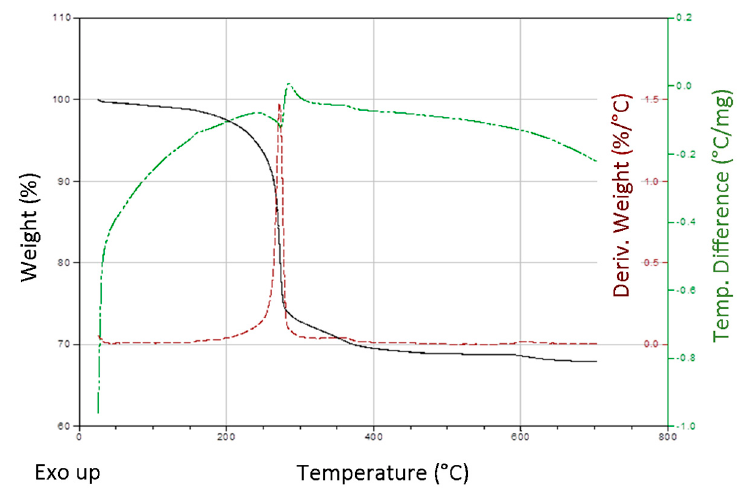
Figure 5. TGA/DTA thermograms of Zn-Carb precursor. Figure 5. TGA / DTA thermograms of Zn-Carb precursor.